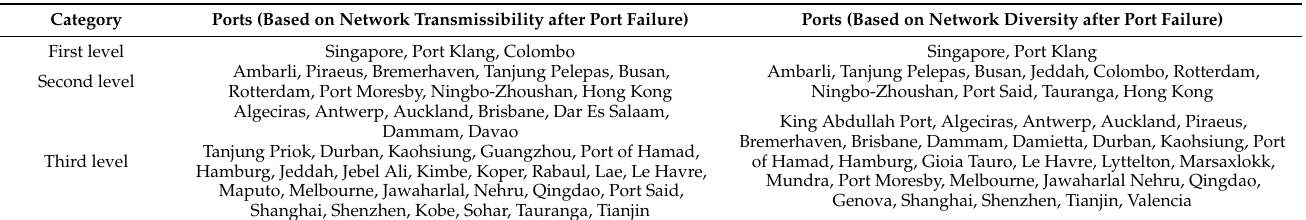
Table 1. Classification of ports along the MSR based on K-means clustering